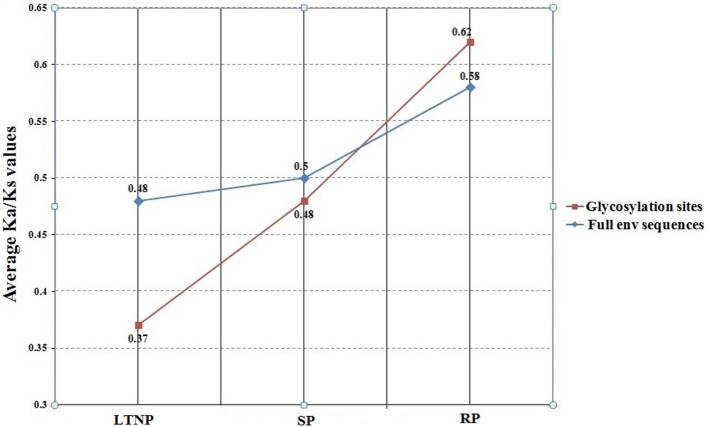
Variation of Ka/Ks of env genes (LTNP, SP and RP) and respective glycosylation sites. LTNP, Long term non-progressor; SP, Slow progressor; RP, Rapid progressor. The blue line refers to the plot of the average Ka/Ks values of the full env sequences of LTNP, SP, and RP. The red line represents the plot of the average Ka/Ks values of the associated glycosylation sites of LTNP, SP, and RP.